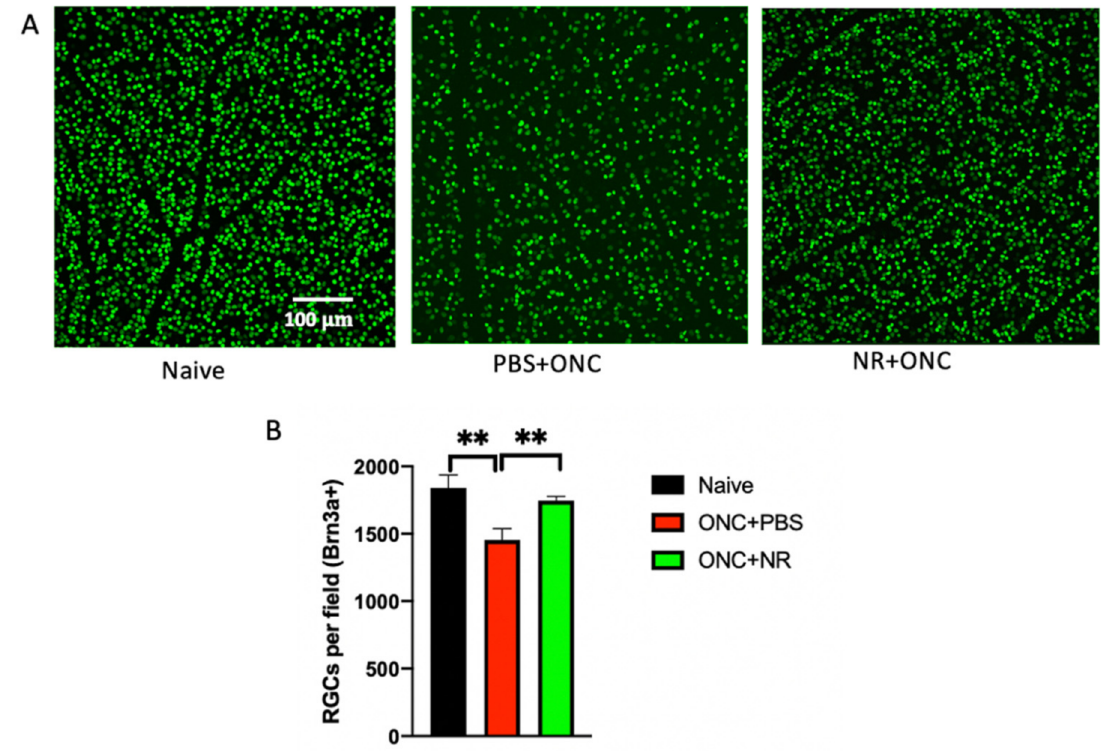
Figure 3. NR treatment prevents RGC loss following ONC. ( A ). Representative images of fields of retinal flatmounts stained for Brn3a+ from each cohort; green fluorescent signal is Brn3a+ immunosignal and is assumed to label RGCs. Mice in the “Naïve” group did not receive ONC or any treatment; the mice in “PBS+ONC” group were i.p. injected with PBS and underwent ONC; the mice in “NR+ONC” group were i.p. injected with NR and underwent ONC. ( B ). Quantification of cells stained with Brn3a+. Retinal flatmounts were prepared from mice of the three cohorts and RGCs were counted in 4 fields per flatmount using a semi-automated, masked protocol. The mean number of RGCs from mice that had been PBS-injected and had undergone ONC (red) were significantly lower than that of the naïve cohort (black). Conversely, the mean number of RGCs from mice that had been NR-injected and had undergone ONC (green) was statistically indistinguishable from that of the naïve cohort (black) and was significantly greater than the mean of mice that had been PBS-injected and underwent ONC (red), indicating that NR treatment prevented RGC loss at 3 days post-ONC. ** p < 0.01, one-way ANOVA Newman-Keuls test. N = 4–6 mice/group. Error bars represent SEM. Scale bar represents 100 µ